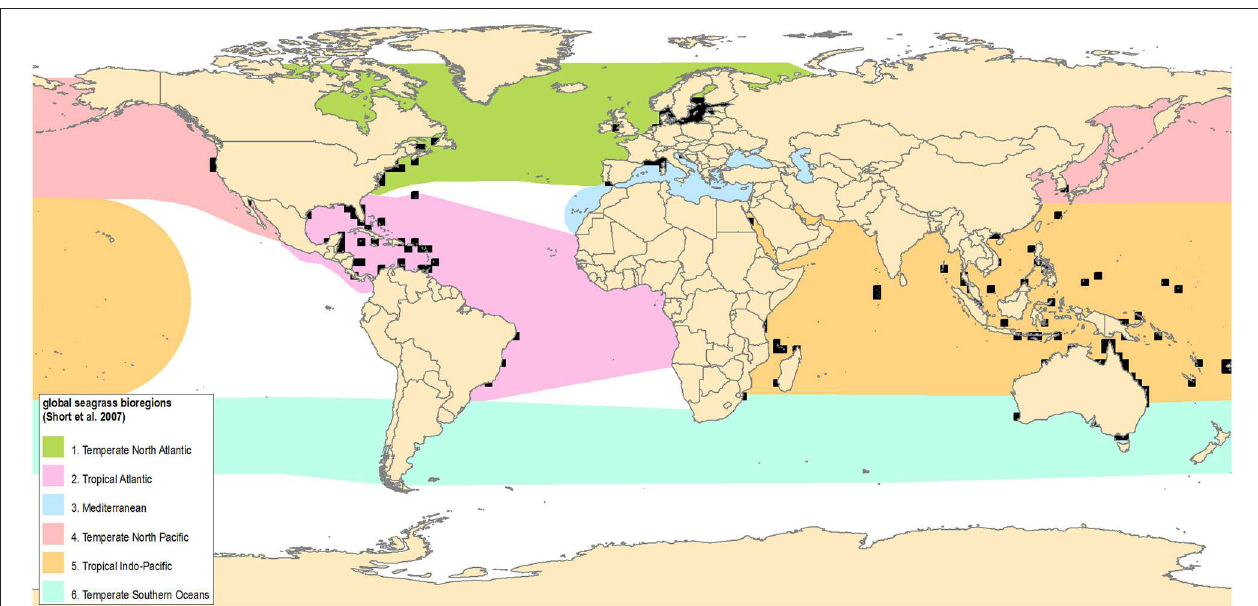
FIGURE 1 | Locations of current long-term seagrass observing networks and seagrass geographic bioregions. (1) Temperate North Atlantic, (2) Tropical Atlantic, (3) Mediterranean, (4) Temperate North Pacific, (5) Tropical Indo-Pacific, (6) Temperate Southern Oceans. Observing systems are shown as 2 degree